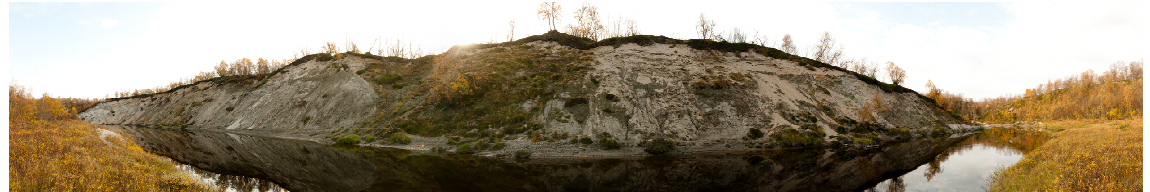
Figure 2. Representative riverbank of the Pulmanki River. The flow direction is from right to